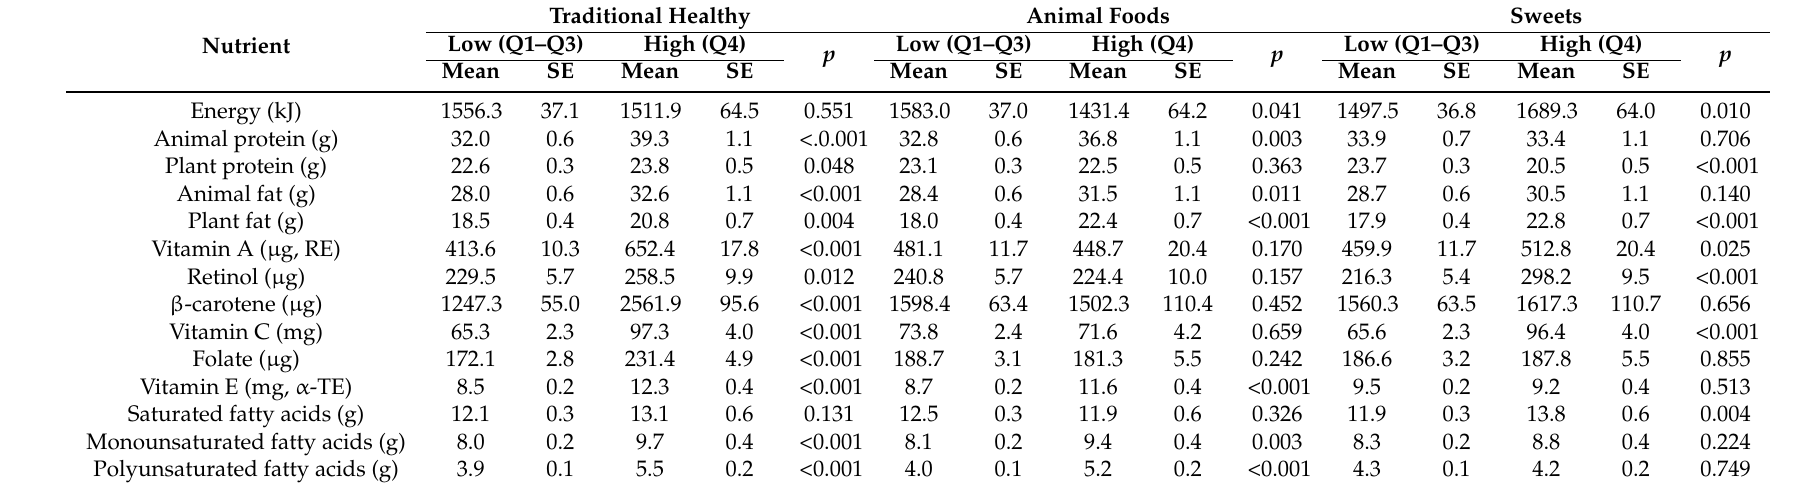
Table 3. Associations of daily nutrient intakes with dietary patterns between the low (Q1–Q3, n = 329) and high (Q4, n = 109) groups